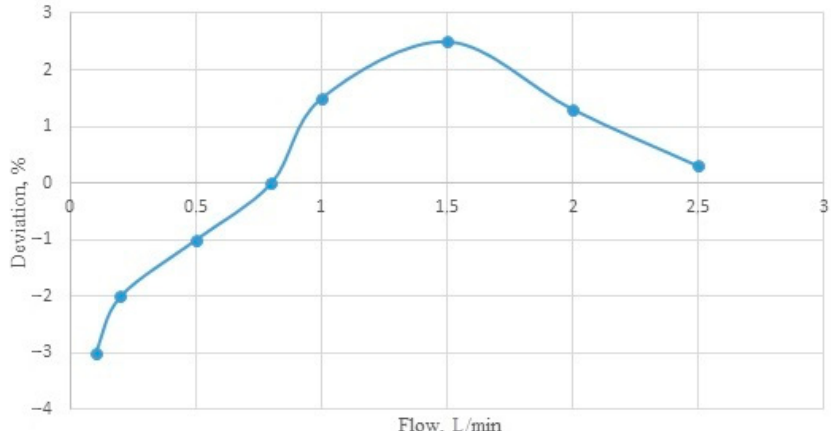
Figure 2. Diagram of the deviation in the measurement results for the flow sensor.